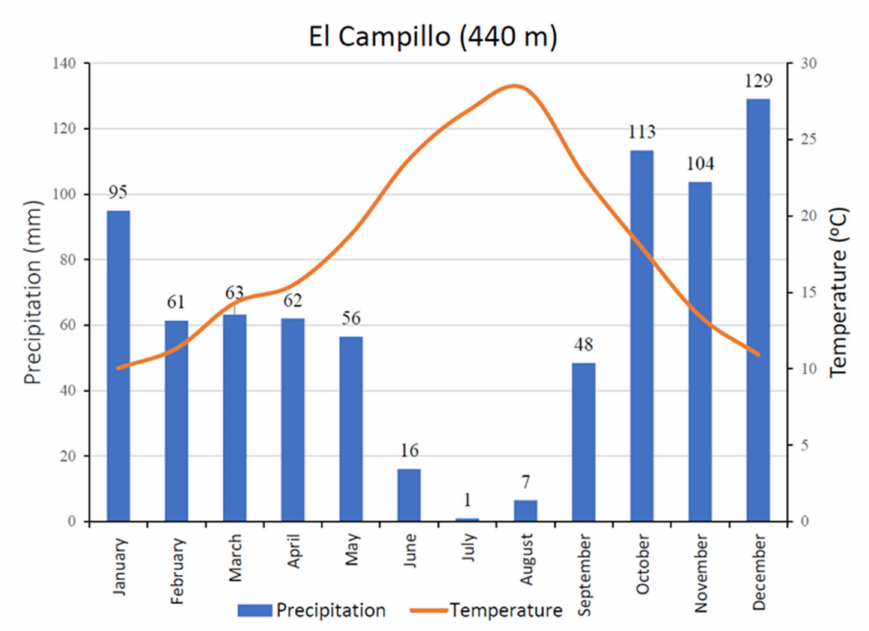
Figure 7. Climograph obtained from the meteorological data of the weather station at El Campillo (37 ◦ 41 (cid:48) 37 (cid:48)(cid:48) N, 6 ◦ 37 (cid:48) 45 (cid:48)(cid:48) W) occurring 7 km SW Pena de Hierro at an altitude of ~430